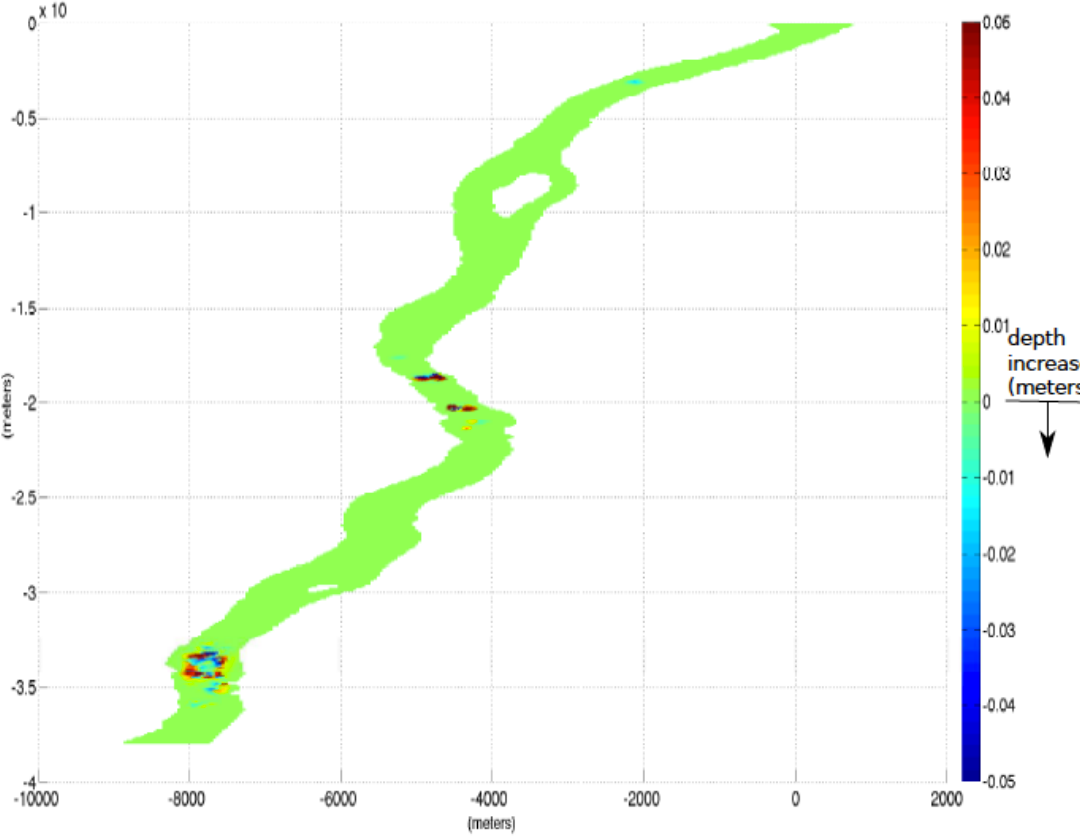
Figure 12. The change in depth along the river caused by